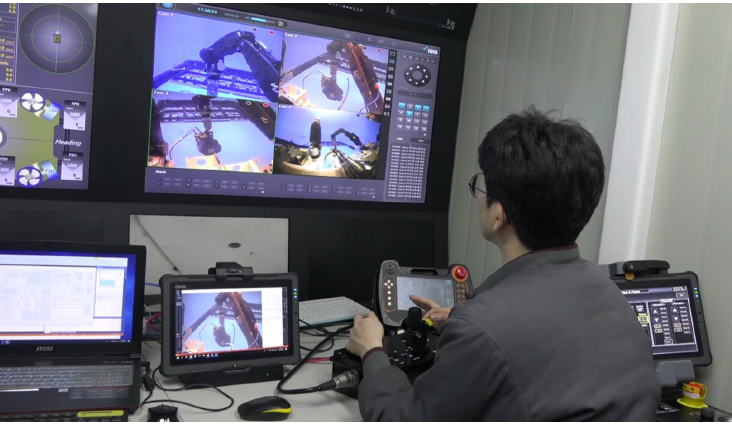
Figure 3. Operating room for